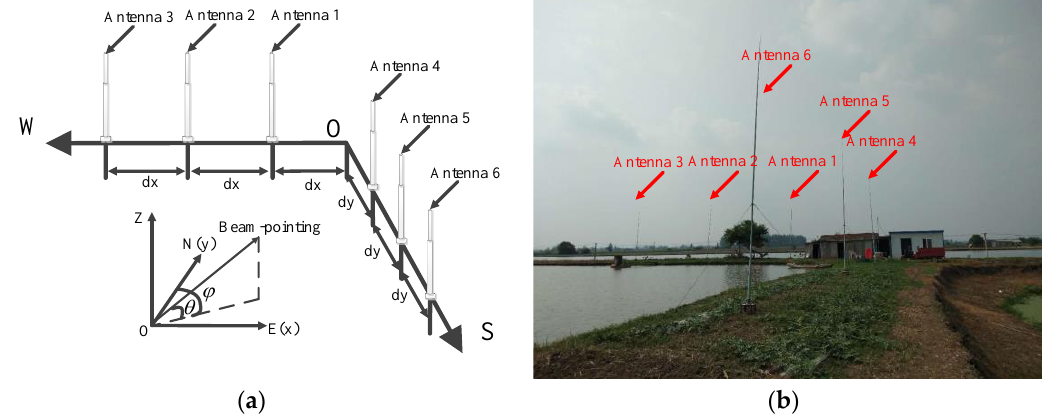
Figure 4. ( a ) The layout of the antenna array; ( b ) the actual scene of the antenna array.